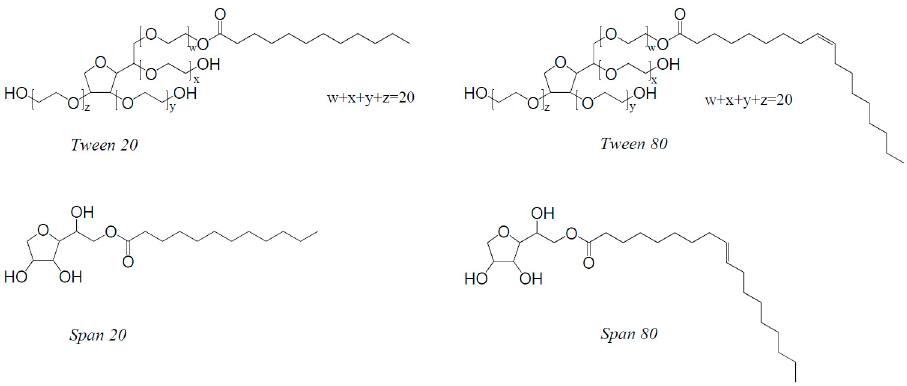
Figure 6. Structural formulae of Tween 20, Span 20, Tween 80, and Span 80. Stability